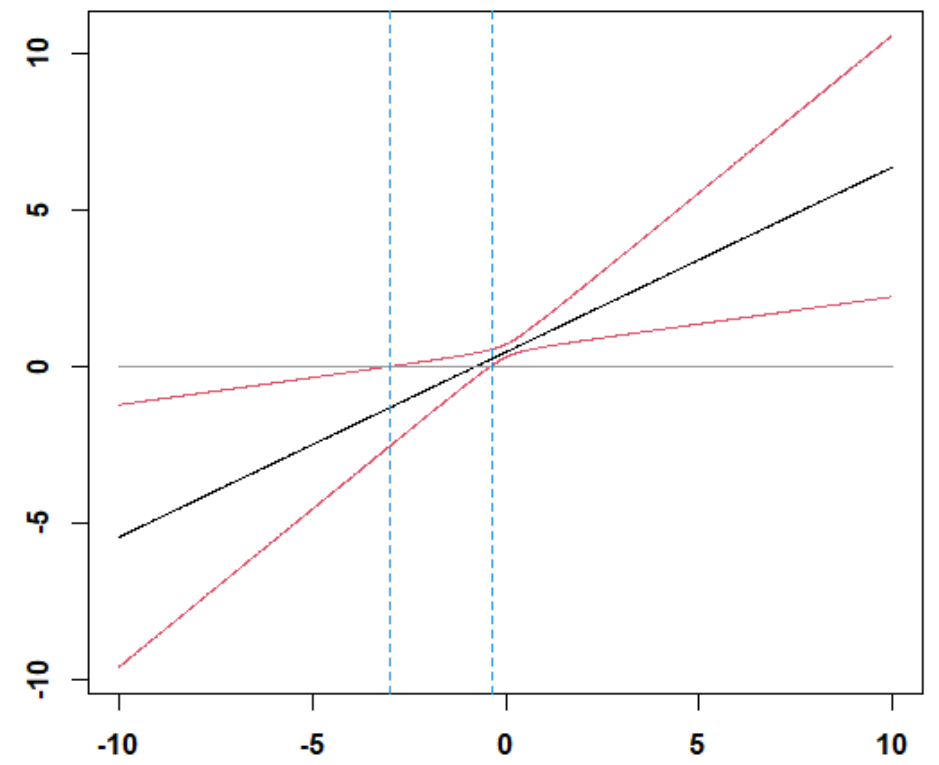
Figure 5. The region of significance of the moderating effect of group minimum competency. Note: The moderating effect is significant when the moderator is greater than −0 .38 and smaller than X-axis: Moderator, Y-axis: Simple −2 .99. X-axis: Moderator, Y-axis: Simple slope.